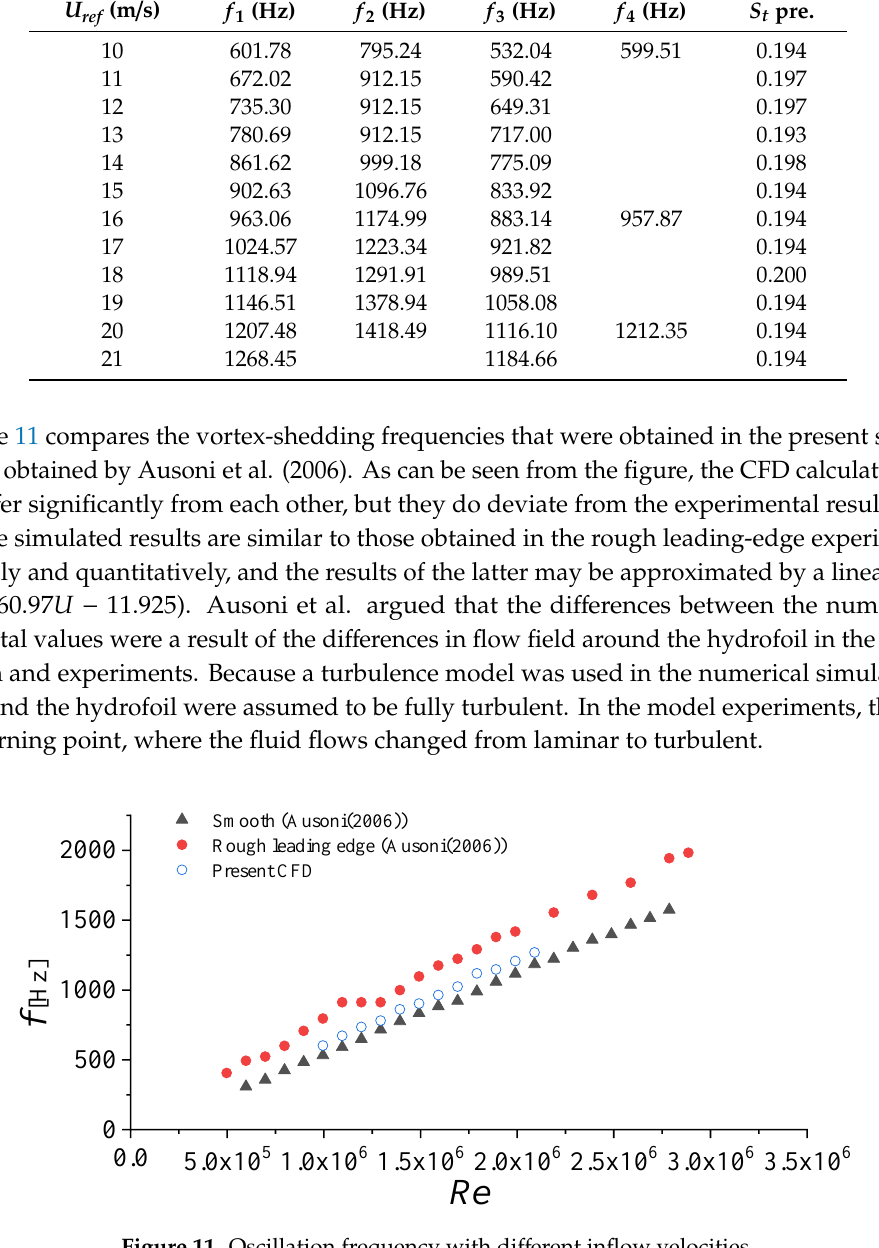
15 200.00 0.25 0.50 Smooth(Ausoni(2006)) Present CFD Rough leading edge(Ausoni(2006)) S t U ref [m/s] Figure 12. Strouhal number at different inflow velocities. 3.3. Effects of the Trailing-Edge Thickness A sharp trailing edge is usually undesirable in marine propellers and hydrofoils. To avoid resonances in marine propellers, an appropriate trailing-edge thickness must be selected to shift the vortex-shedding frequency away from the natural frequencies of the propeller. Therefore, numerical studies on the relationship between the vortex-shedding frequency and trailing-edge thickness are highly important. The NACA0009 hydrofoil was truncated at different positions to investigate the effects of the trailing-edge thickness ( b ) on vortex shedding. The inflow velocity 𝑈 𝑟𝑒𝑓 was set to 12 m/s, and the thickness of the boundary-layer mesh was set according to the chord length of the hydrofoil. Each set of vortex shedding data in Table 5 corresponds to a hydrofoil shape with a different truncation. Table 5. Vortex-shedding frequency corresponding to each trailing-edge thickness.